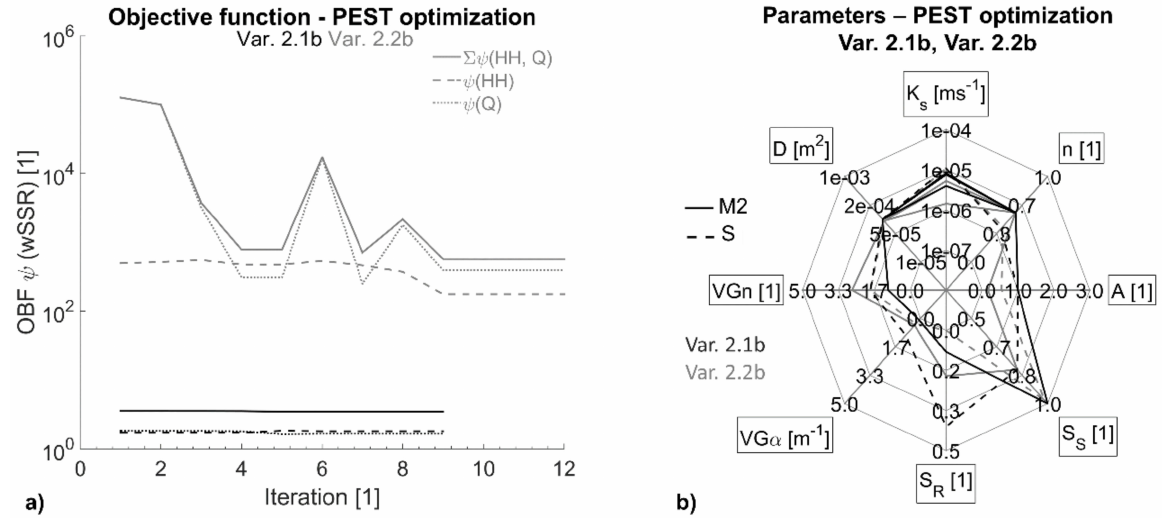
Figure 10. ( a ) PEST OBF for Var. 2.1b and Var. 2.2b; ( b ) estimated parameters for Var. 2.1b and Var. 2.2b.